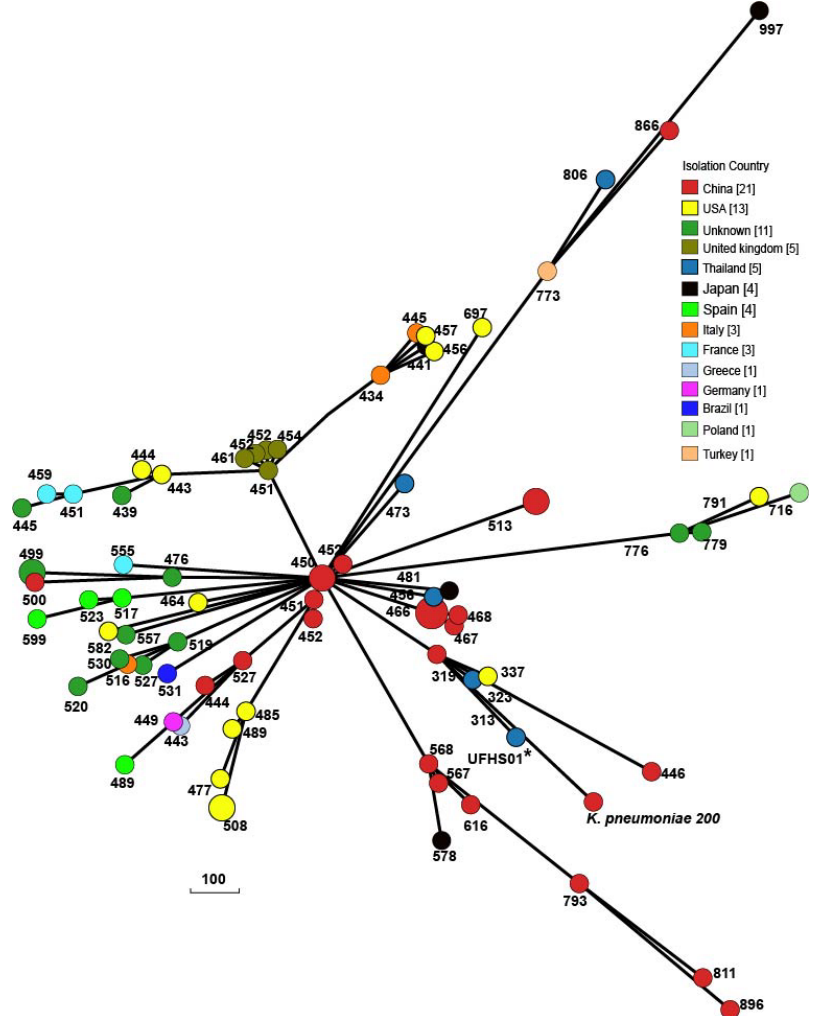
Figure 1. Phylogenetic trees of all ST37 K. pneumoniae strains of released public sequences based on cgMLST. The evolutionary distance showed that K. pneumoniae 200 was related to human-associated K. pneumoniae 4300STDY6470454 (UFHS01) from Thailand. The numbers indicate the number of allele differences between K. pneumoniae 200 and other isolates.